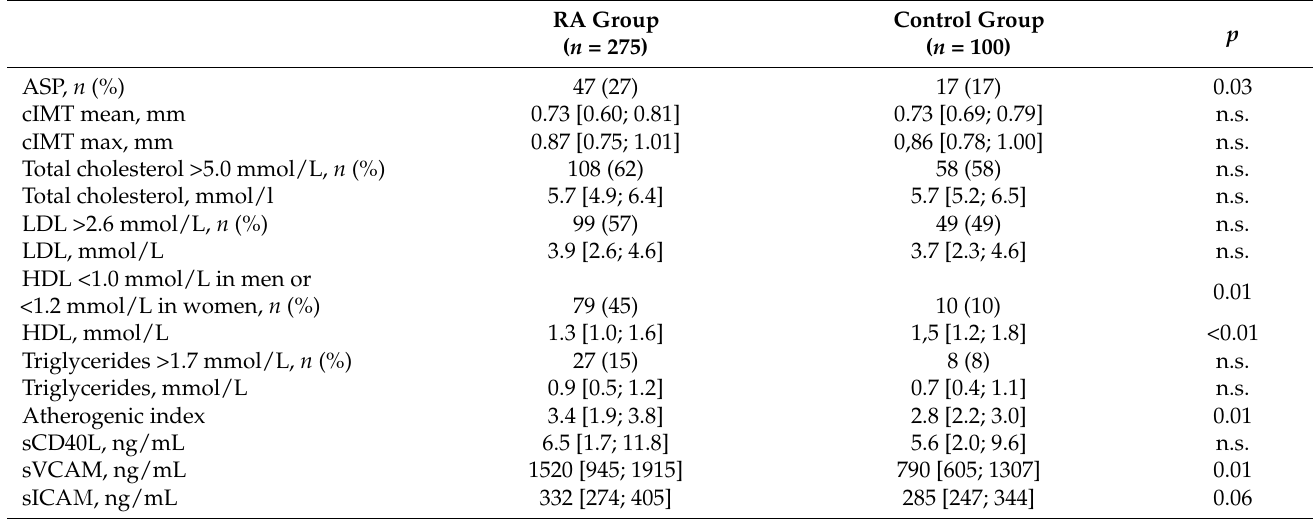
Table 2. Comparison of traditional cardiovascular risk factors, atherosclerosis measurements, blood levels of sCD40L, and adhesion molecules in RA and control patients. RA Group Control ( n = 275)